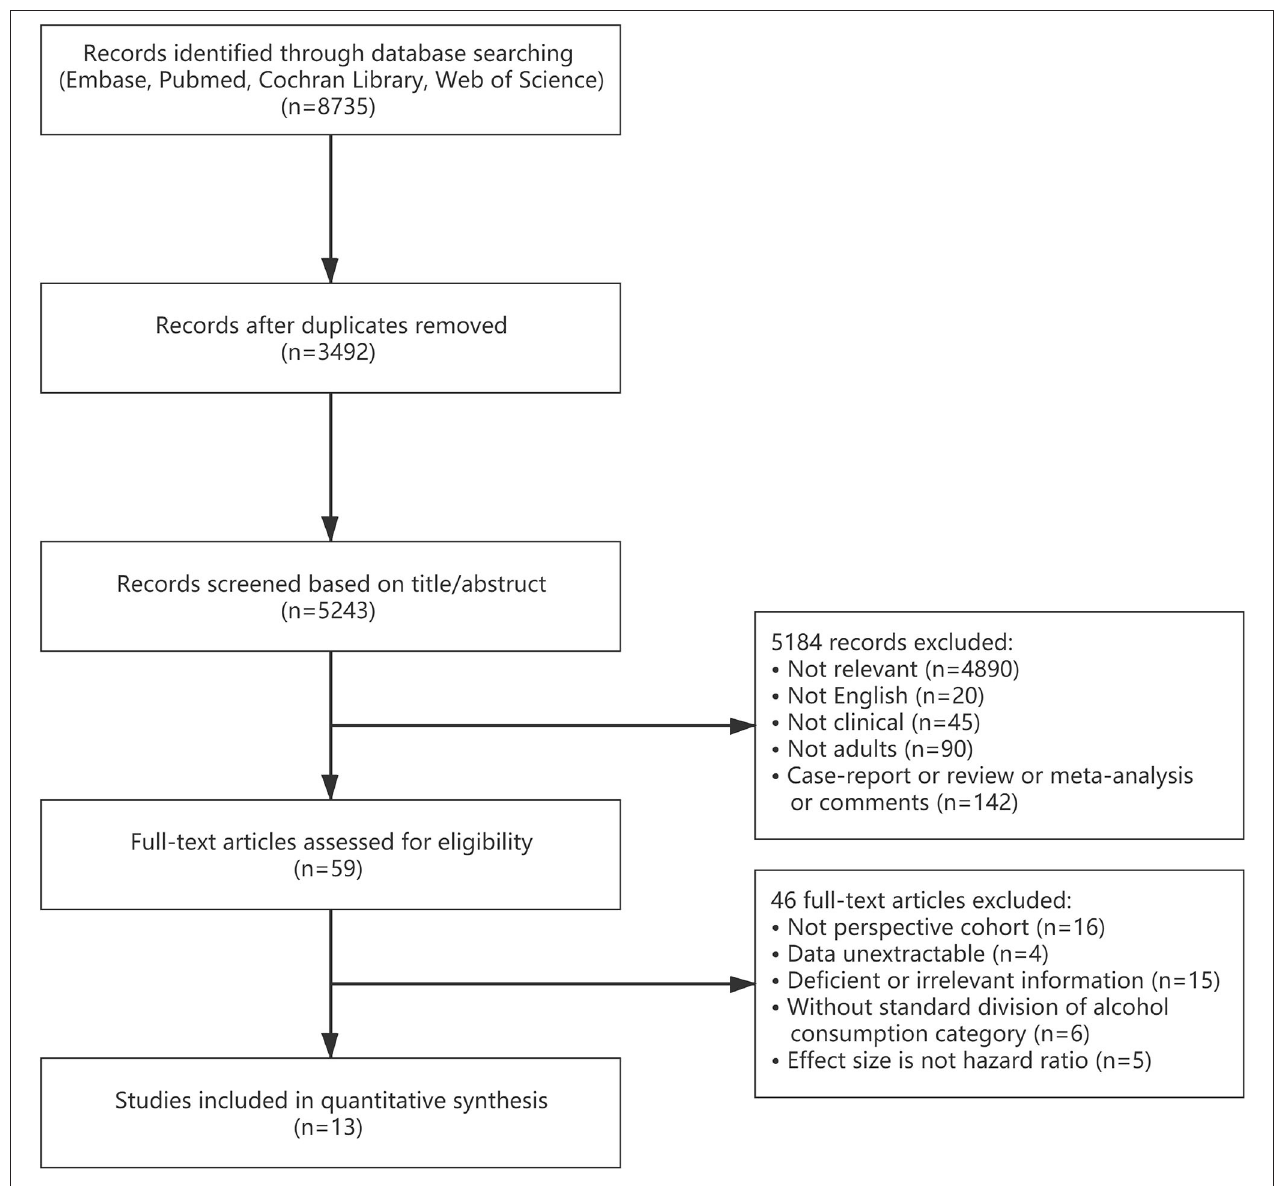
FIGURE 1 | The flow chart of the study selection